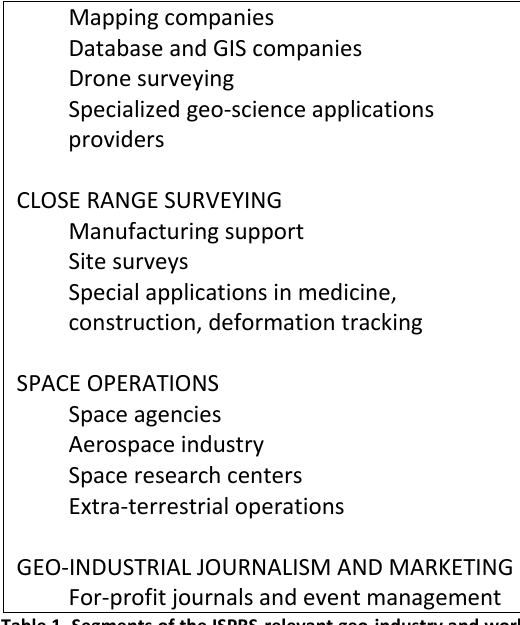
Table 3: From the ISPRS website at http://www.isprs.org/members/adv_of_sust.aspx. List of benefits of sustaining